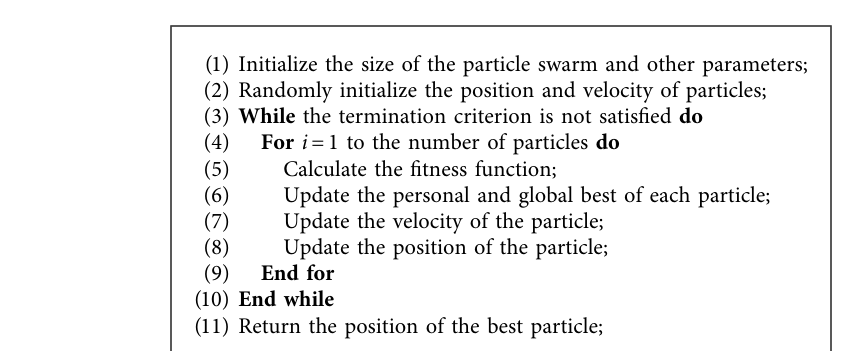
Figure 5: Block schematic for the proposed PID controller [15].